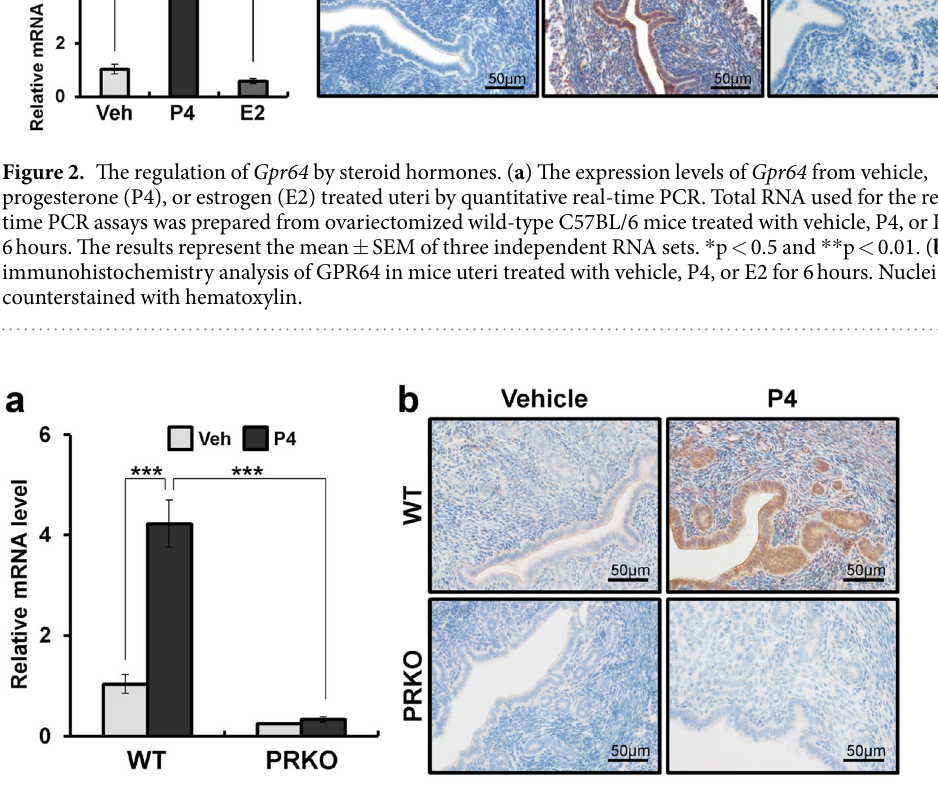
Figure 3. The expression of Gpr64 in PRKO mice uteri by P4 signal. ( a ) The expression levels of Gpr64 from P4 treated wild-type or PRKO uteri by quantitative real-time PCR. Total RNA used for the quantitative real-time PCR was prepared from wild-type or PRKO uteri treated with vehicle or P4 for 6 hours. The results represent the mean ± SEM of three independent RNA sets. *** p < 0.001. ( b ) The immunohistochemistry analysis of GPR64 in vehicle or P4-treated uteri. Uterine sections were collected from vehicle or P4 treated wild-type and PRKO mice for 6 hours. Nuclei were counterstained with hematoxylin.